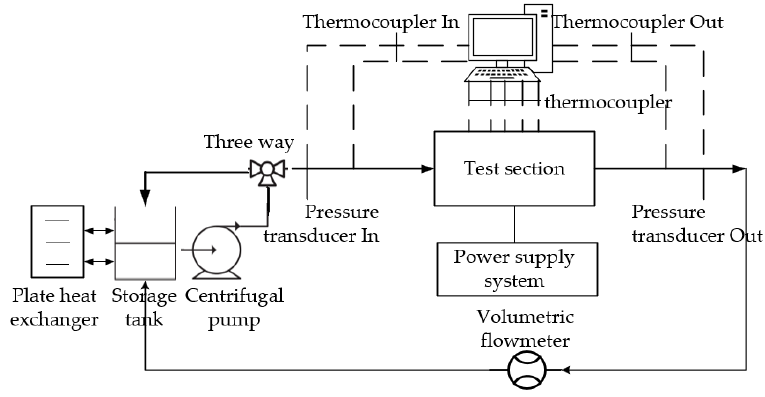
Figure 4. Schematic of the thermal–hydraulic test facility.